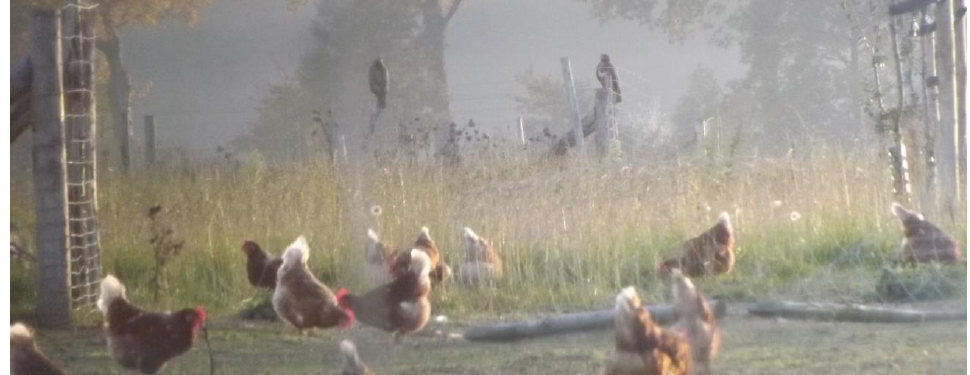
Figure 2. Hens on farm 8 performed normal foraging behaviour (‘walking with pecking and